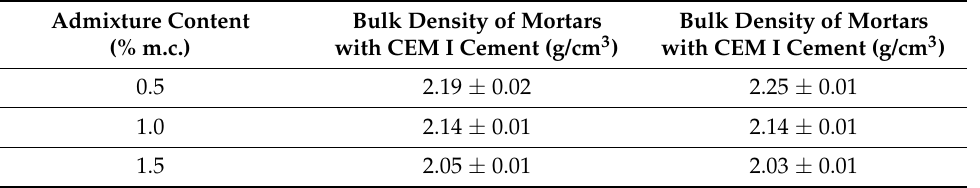
Table 3. Increase in mortar sample height in relation to reference bars depending on the amount of gas-liberating admixture.